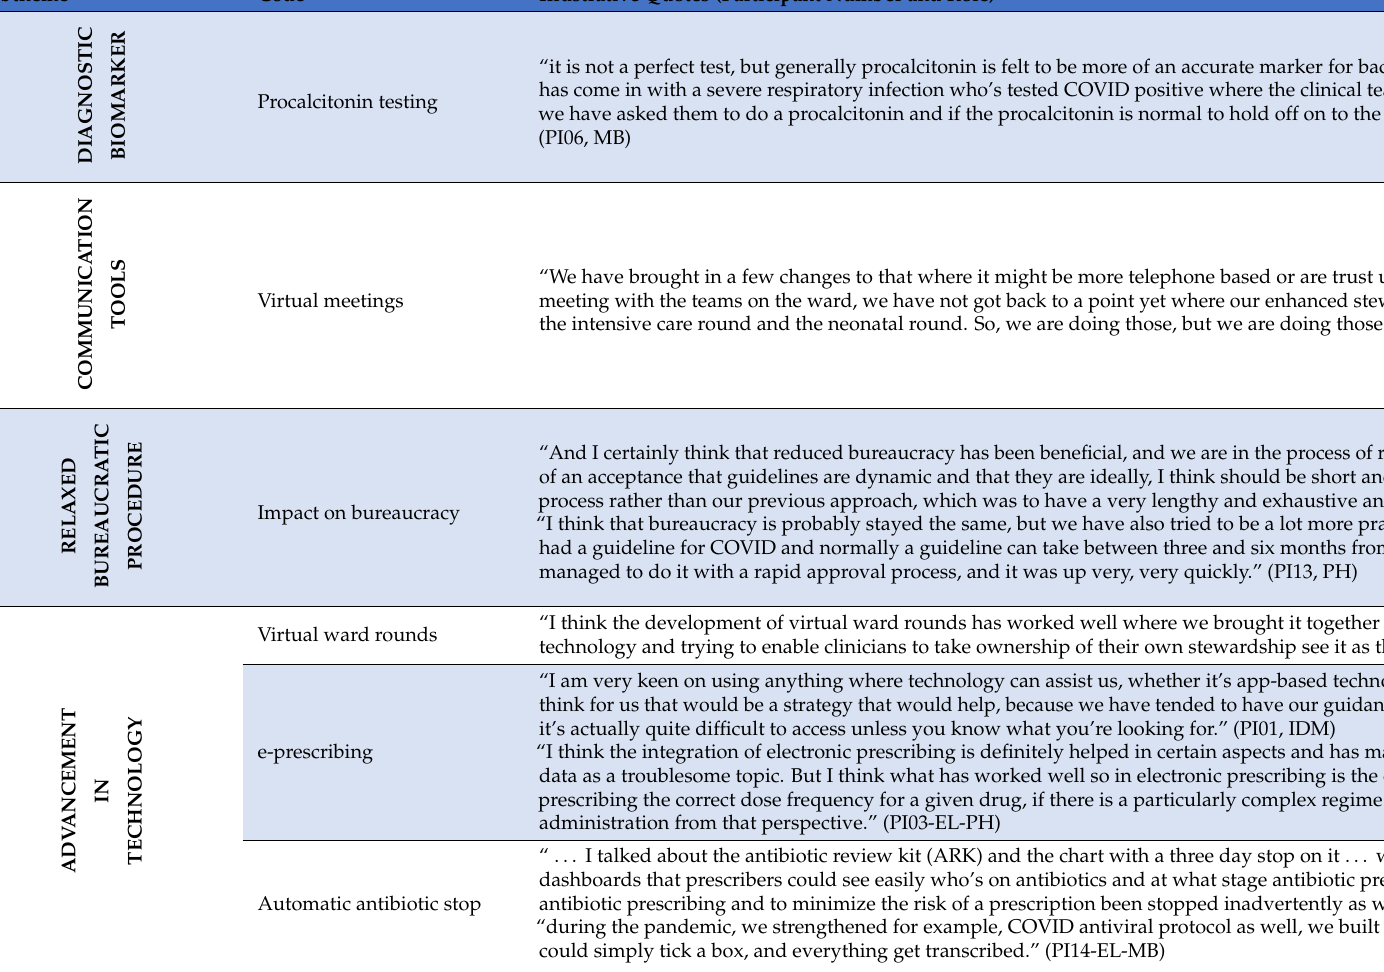
Table 5. THEME FOUR: New AMS activities/strategies adopted during the